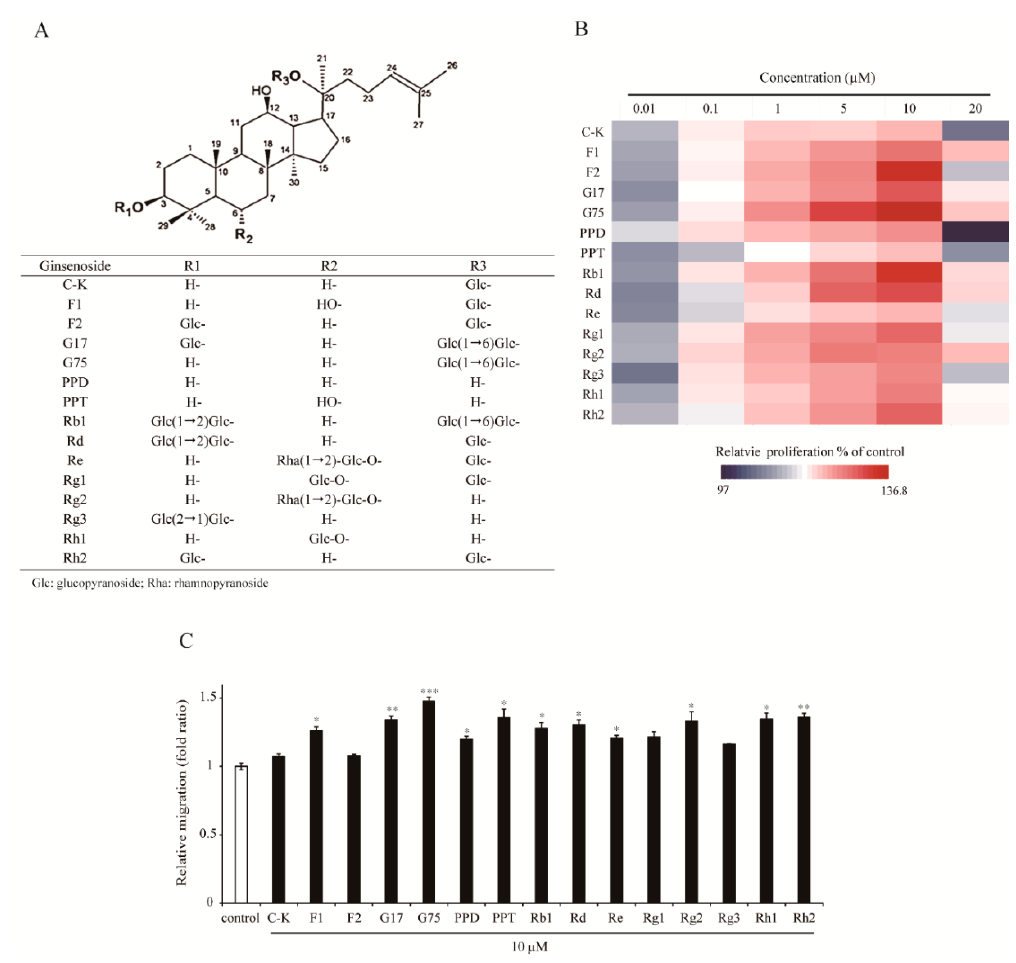
Figure 1. Chemical structure of ( A ) ginsenoides. ( B,C ) Comparison of the effect of various ginsenosides on HaCaT keratinocyte cell proliferation and migration. ( B ) HaCaT cells were treated with various concentrations of ginsenosides (0.01–20 µM) or dimethyl sulfoxide (DMSO, vehicle control) for 48 h. Cell proliferation was then evaluated using MTT assay. Heatmaps showed the relative proliferation induced by different types of ginsenosides. Colors indicate relative proliferation values from the lowest (blue) to the highest (red). ( C ) Scratch wounds were created on monolayer of HaCaT cells, and photographed immediately after wounding (0 h) using phase-contrast microscopy. Cells were incubated with 10 µM of each indicated ginsenoside for 24 h and photographed (24 h). Relative migration was calculated by analyzing the measured wound closure area. DMSO was used as a vehicle control. The bars represent the mean ± SEM of three independent assays. * p < 0.05, ** p < 0.01, *** p < 0.001, two-tailed Student’s t -test.